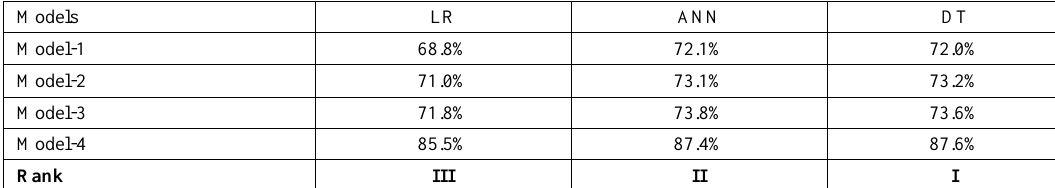
Table 10. ROC values of Logistic, ANN and Decision Tree